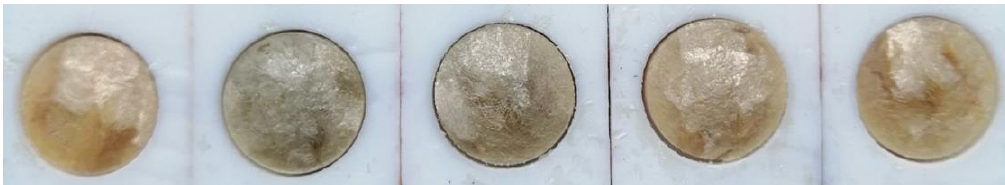
Figure 2. The final samples resulted after freeze drying and thermal treatment.